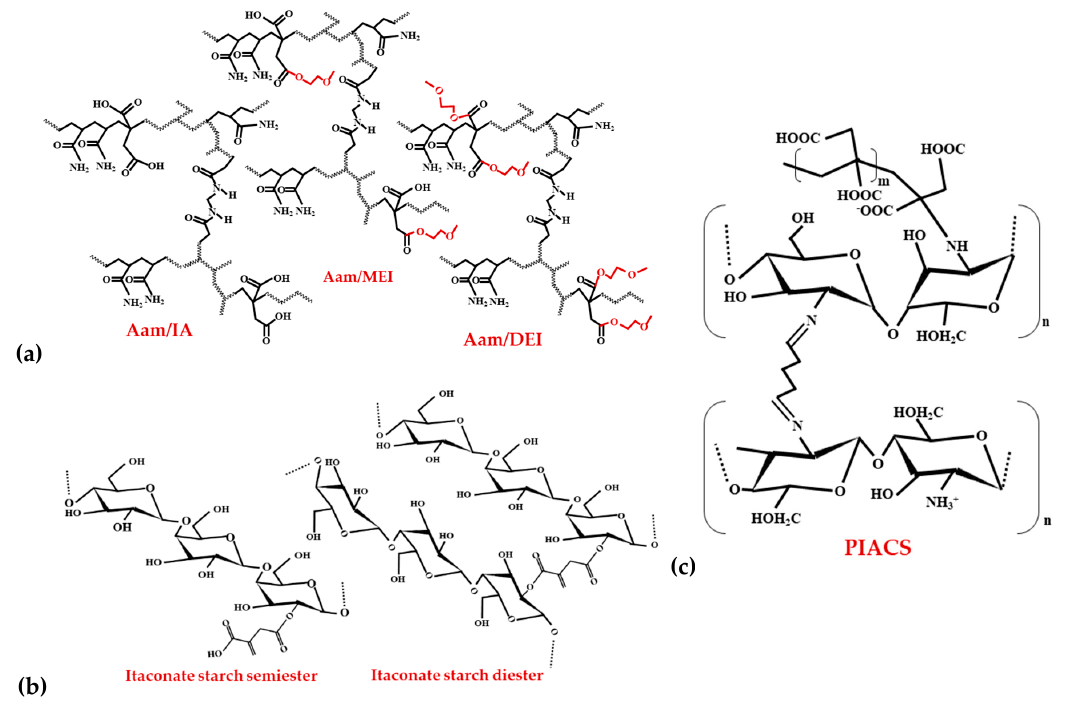
Figure 5. The chemical structure of IA synthesized hydrogels ( a ) Aam / IA, Aam / MEI, Aam / DEI ( b ) Itaconate starch semi- and diester ( c ) PIACS.